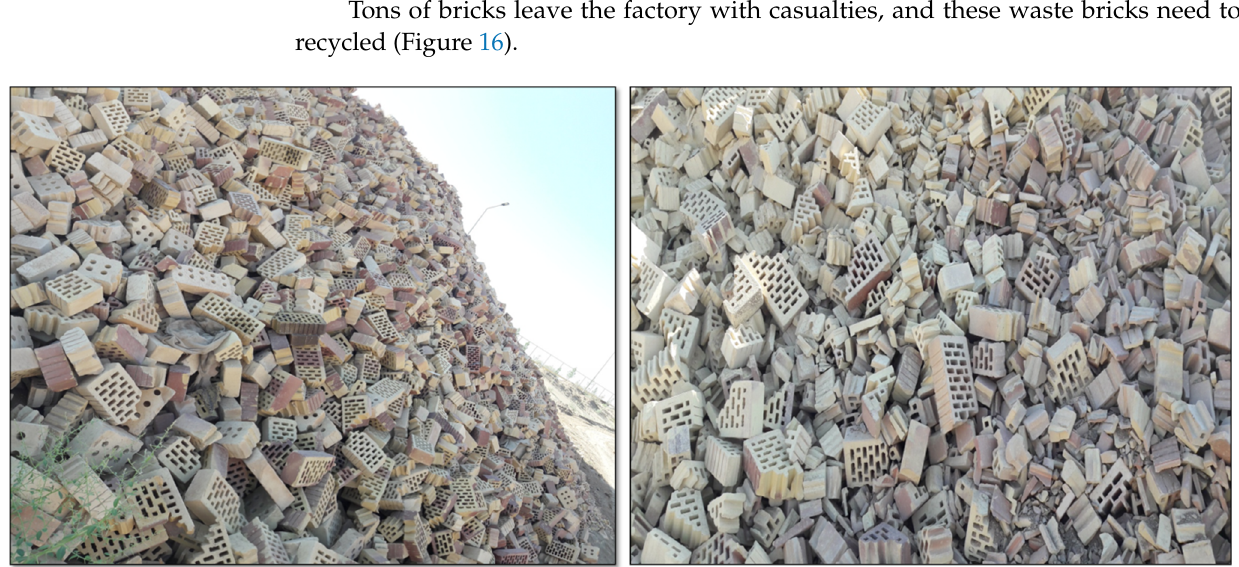
Figure 16. Ceramic waste bricks from the factory.